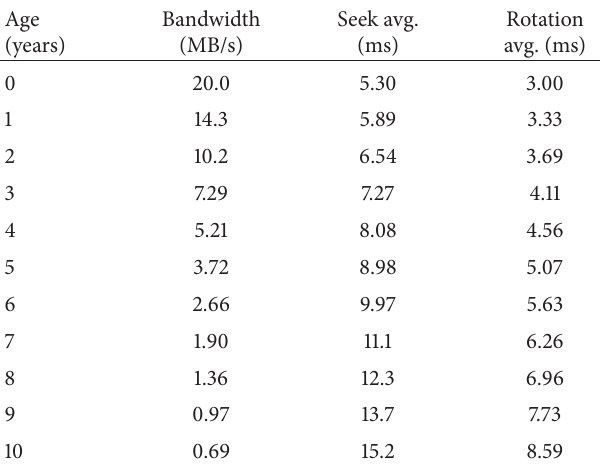
Table 2: We model different performance of disks based on IBM 9LZX manufactured in progressively order